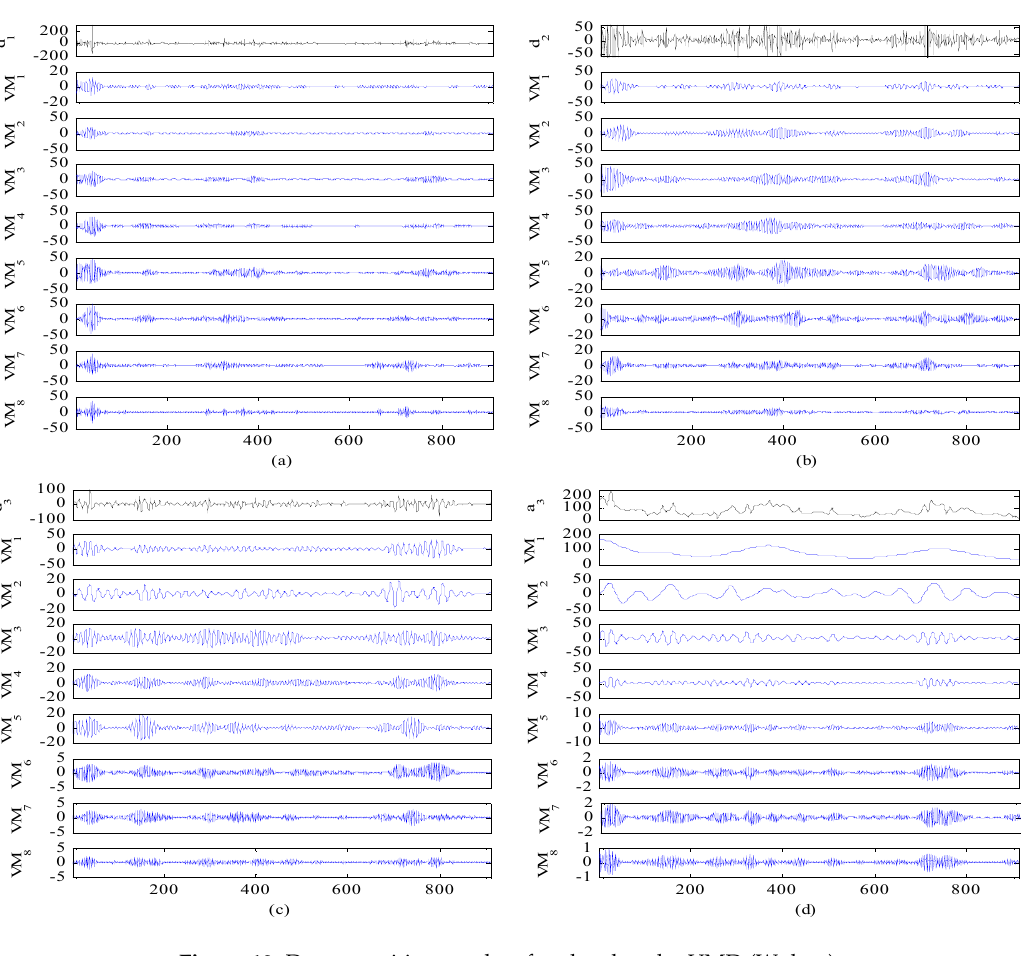
Figure 10. Decomposition results of each subset by VMD (Wuhan). Int. J. Environ. Res. Public Health 2017 , 14 , 764